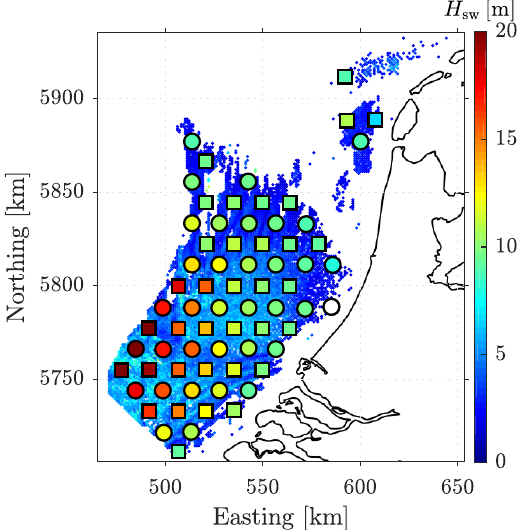
Figure 8. Modeled sand wave heights H mod sw on both calibration (circles) and validation locations (squares). The background shows observed sand wave heights H obs sw [12,33]. White markers indicate locations for which the model predicts no sand waves to occur.